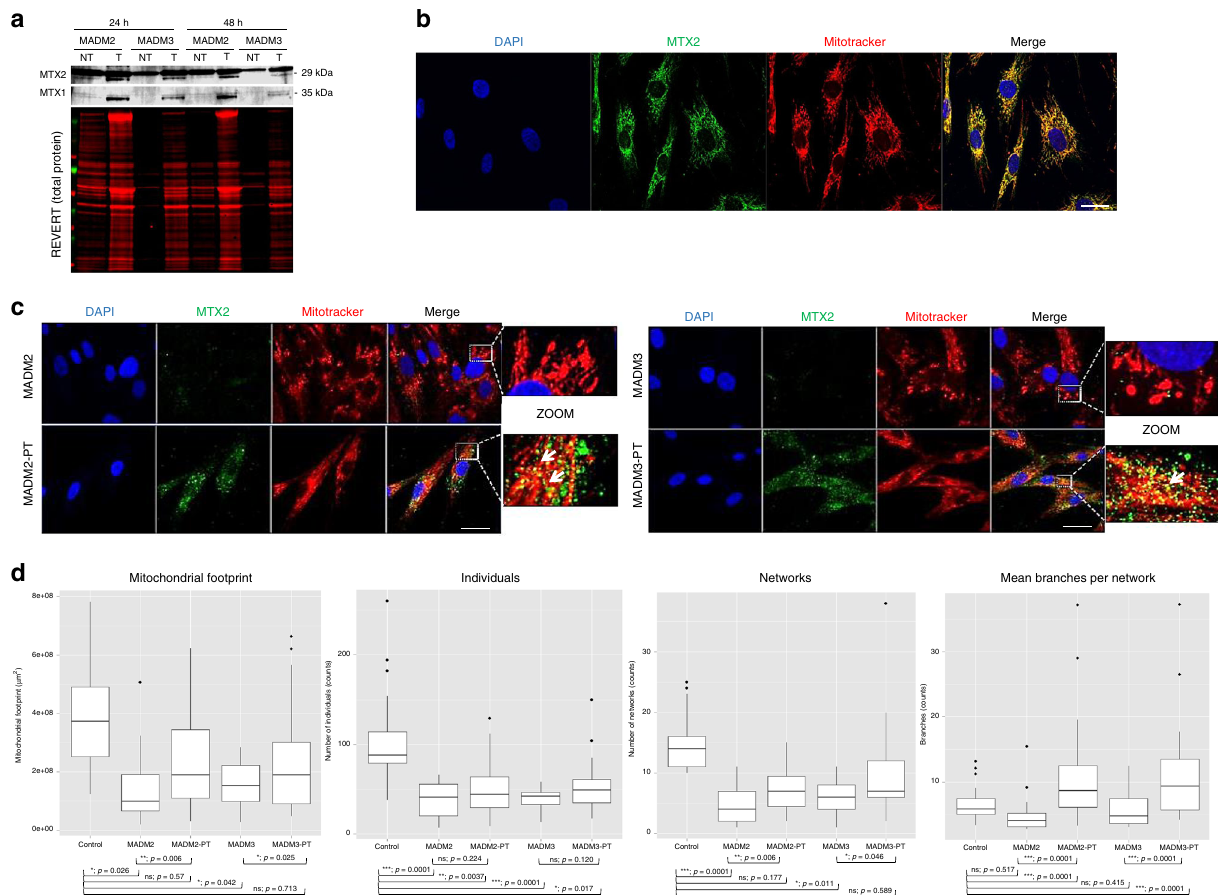
Fig. 6 MTX2 overexpression by cDNA transfection rescues pathological phenotypes. a Western blots were performed 24 and 48 h post MTX2 -cDNA transfection in MADM2 and MADM3 patients ’ fi broblasts (NT nontransfected, T transfected). The data are representative of one experiment. b Immuno fl uorescence staining of MTX2 (green), Mitotracker (red), and DAPI (blue) in control fi broblasts showing colocalization of MTX2 with mitochondria. The data are representative of one experiment. Scale bar, 10 µ m. c Immuno fl uorescence staining of MTX2 (green) and Mitotracker (red) 48 h post MTX2 -cDNA transfection in MADM2 and MADM3 patients ’ fi broblasts (PT post transfection). Colocalization of overexpressed MTX2 with mitochondria is shown (arrows in the zoomed images). The data shown are representative of one experiment. Scale bar, 10 µ m. d Mitochondrial network analysis using the MINA toolset on healthy and MADM2 and MADM3 patients ’ fi broblasts before and after MTX2 -cDNA transfection showing improved mitochondrial footprint, individuals, networks, and branches per network for all parameters in PT conditions, when compared either to the patient ’ s nontransfected cells or to control cells. Box plots show median (horizontal lines), fi rst to third quartile (box), and the most extreme values within 1.5 times the interquartile range (vertical lines). Outliers are shown as well. n = 29 (WT), 27 (MADM2), 27 (MADM2-PT), 28 (MADM3), and 25 (MADM3-PT) cells from one experiment were blindly scored. Differences between control and patients were analyzed by Kruskal – Wallis test with multiple-comparison and exact p values are indicated in the fi gure. * p < 0.05, ** p < 0.01, *** p < 0.001, ns not signi fi cant. Source data are provided as a Source Data fi